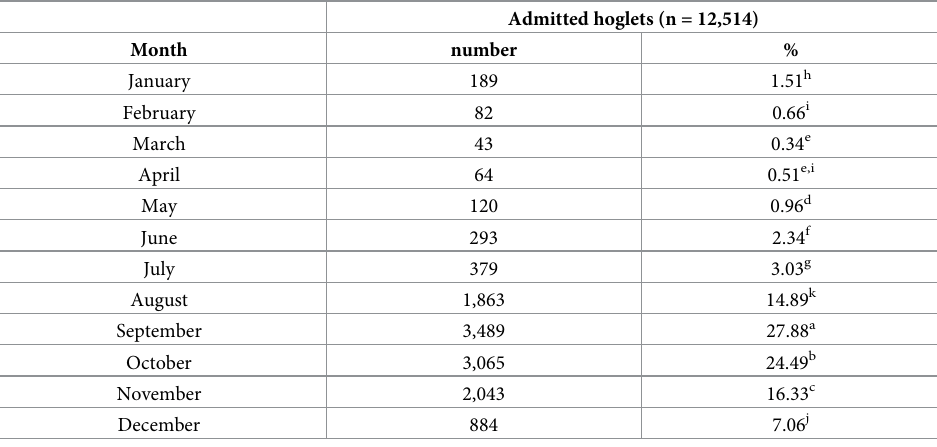
Table 1. Number and percentage of the total number of juvenile European hedgehogs admitted to rescue centers by individual months in the period from 2010 to